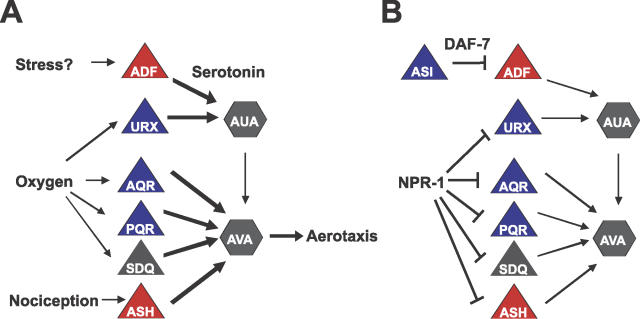
A Distributed Network of Oxygen-Sensing Neurons(A) Aerotaxis-promoting neurons. In the absence of food, parallel networks of sensory neurons generate hyperoxia avoidance. Triangles denote sensory neurons; hexagons denote interneurons. URX, AQR, and PQR, and SDQ, ALN, and BDU neurons (abbreviated as “SDQ” for simplicity) express sGCs; these neurons are likely oxygen sensors. ASH and ADF neurons express the TRPV channels osm-9 and ocr-2; they might be modulatory neurons, or might respond to oxygen directly. ADF promotes aerotaxis by producing serotonin. Our genetic results suggest that robust aerotaxis requires at least one class of sGC neuron and at least one class of TRPV neuron. Synaptic connections to the AUA interneurons and AVA backward command neurons are shown; additional synapses are omitted [34].(B) Aerotaxis-suppressing pathways. In the presence of food, the aerotaxis neurons are inhibited by the TGF-β homolog DAF-7 and the neuropeptide receptor NPR-1. Food and tax-4 activity in ASI neurons stimulate the synthesis of DAF-7, which acts through DAF-3 to inhibit serotonin production in ADF and suppress aerotaxis. Increased or unregulated serotonin expression in ADF allows aerotaxis in the presence of food. Food inhibition may involve additional food-sensing pathways in ADF (perhaps via osm-9 and ocr-2) or serotonin signaling from other food-sensing neurons (such as NSM). NPR-1 is expressed in URX, AQR, PQR, ASH, SDQ, and AUA neurons [14] and could inhibit their function in a food-dependent or food-independent fashion. Many of the signaling pathways and neurons described here have the potential to regulate each other's activity. tph-1 mutants have decreased daf-7 expression [30], and daf-7 affects gene expression in the ASH neurons [47]. A food-related change in serotonin levels affects nociceptive signaling in ASH [38]. The NPR-1 ligand FLP-21 is expressed by ASH and ADL [15]. The regulatory relationships in (B) are supported by the genetics, molecular biology, and behavioral assays in this paper, but these relationships could be reconfigured under different conditions.